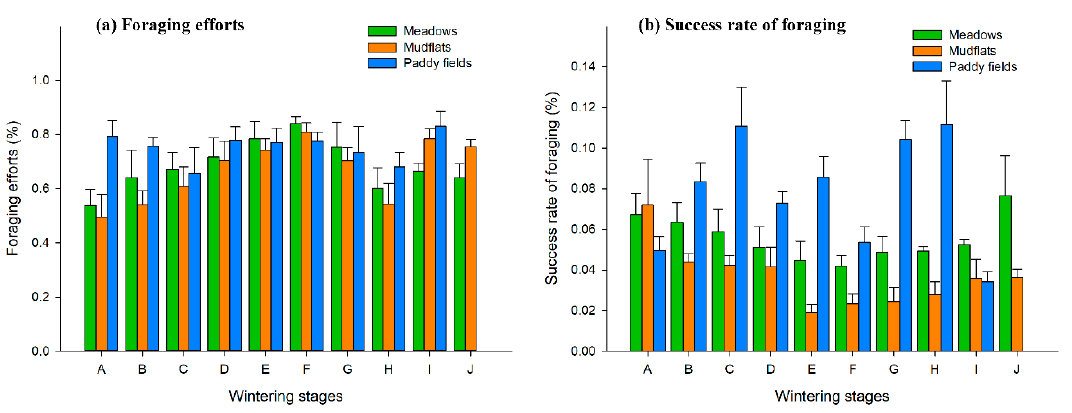
Figure 3. Dynamic changes of foraging efforts ( a ) and success rate of foraging ( b ) during wintering at Shengjin Lake (A–J stand for wintering stages, and their meaning is shown in Section 2.2).